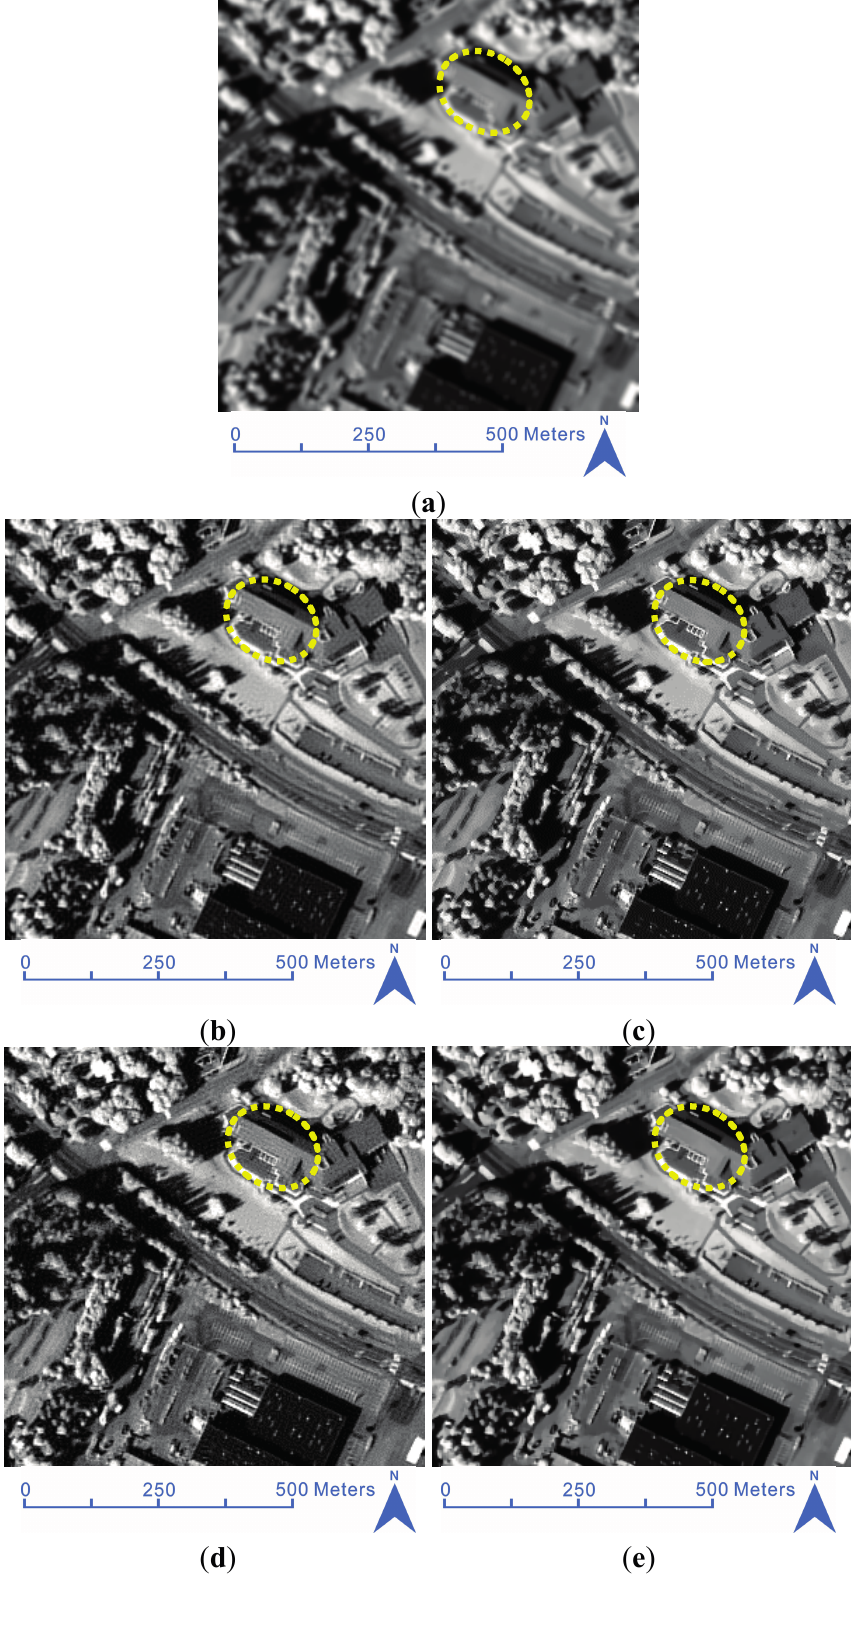
Figure 6. Comparison of the results for the SPOT image in the noise-free case: ( a ) degraded image by a 5 5 × truncated Gaussian PSF; ( b ) restored image of the MLO method; ( c ) restored image of the AM-Sparse method; ( d ) restored image of the AM-HMRF method; ( e ) restored image of the AM-KEdge